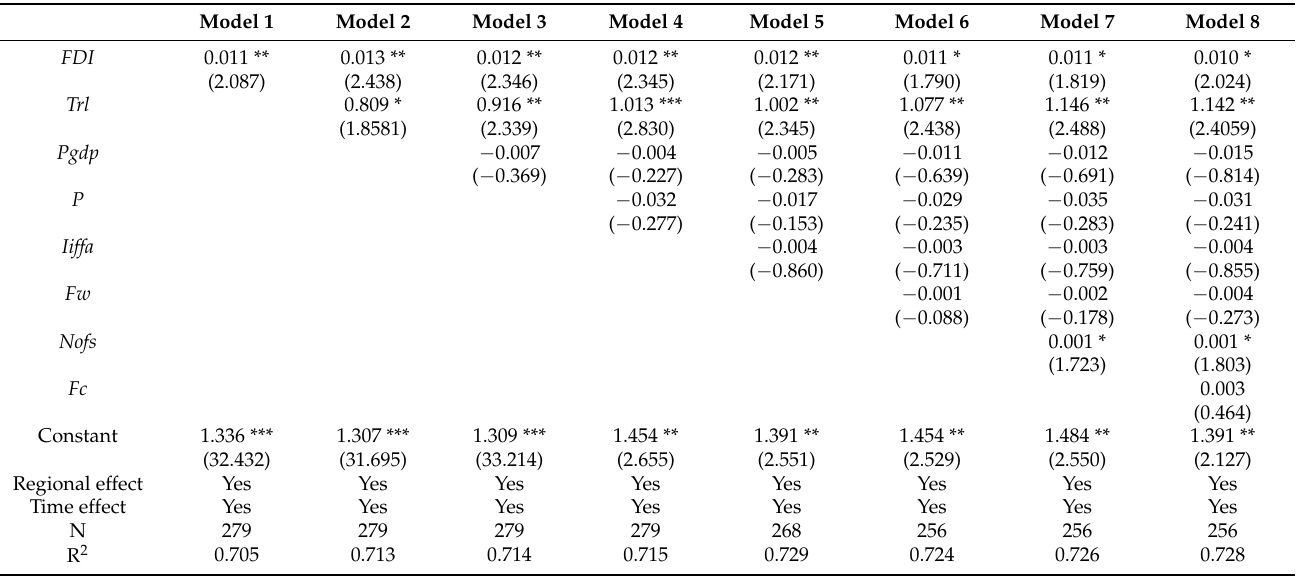
Table 6. Estimated results of the impact of FDI in forestry and labor migration on the forestry industry structure